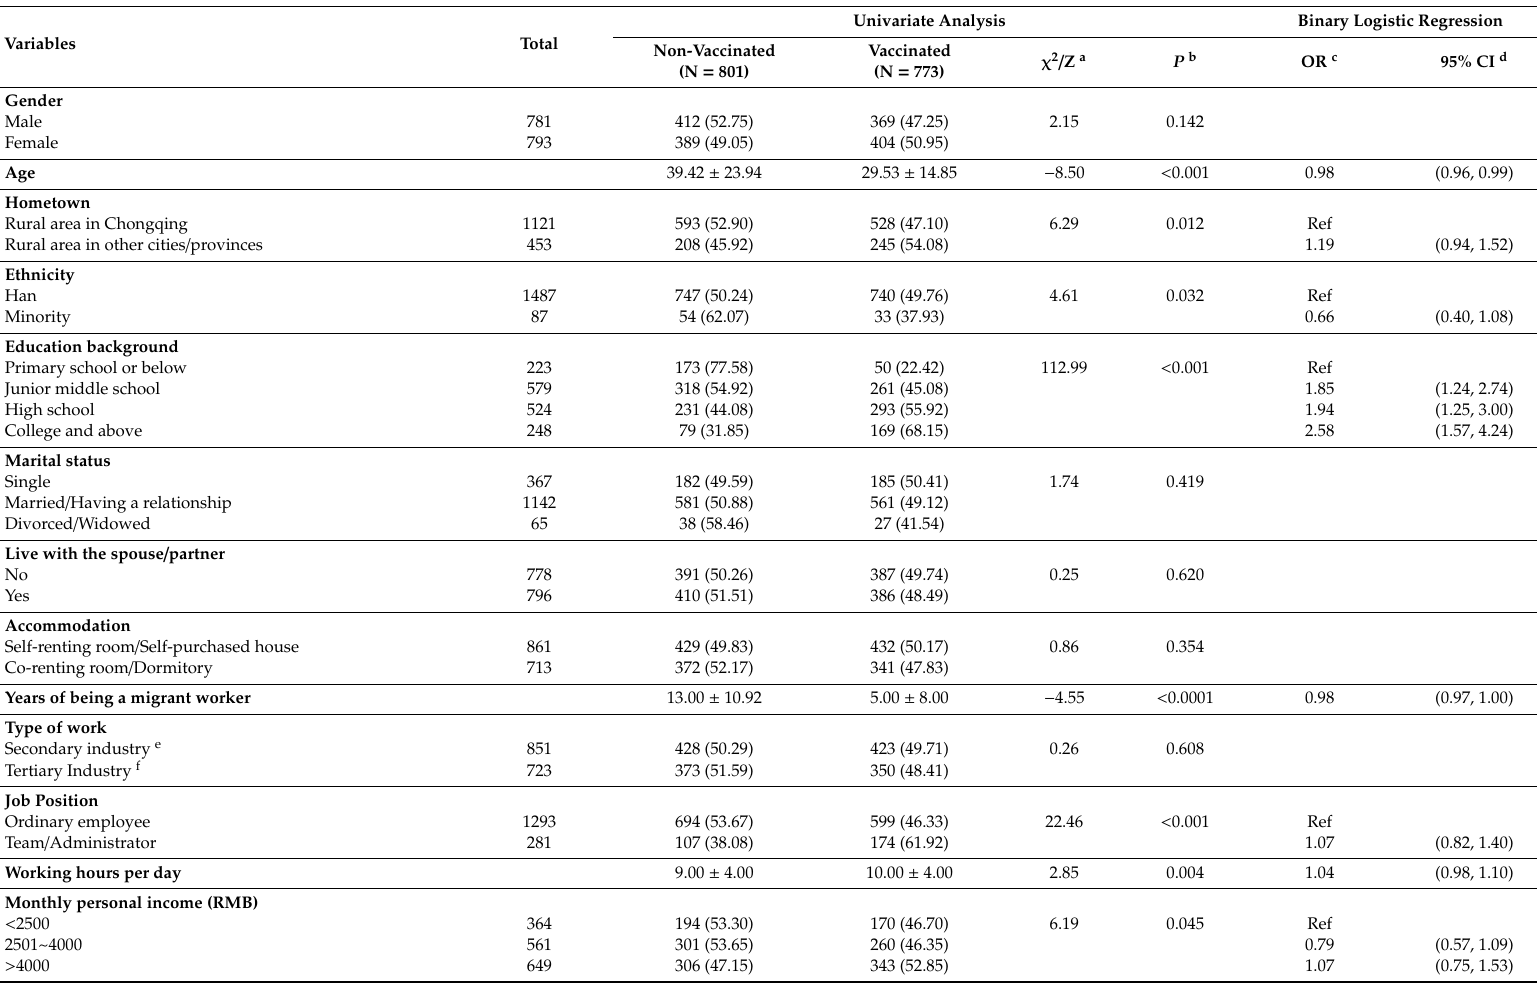
Table 1. Univariate analysis and binary logistic regression on factors associated with vaccination status in hepatitis B vaccination (HBV) vaccine for migrant workers (N =